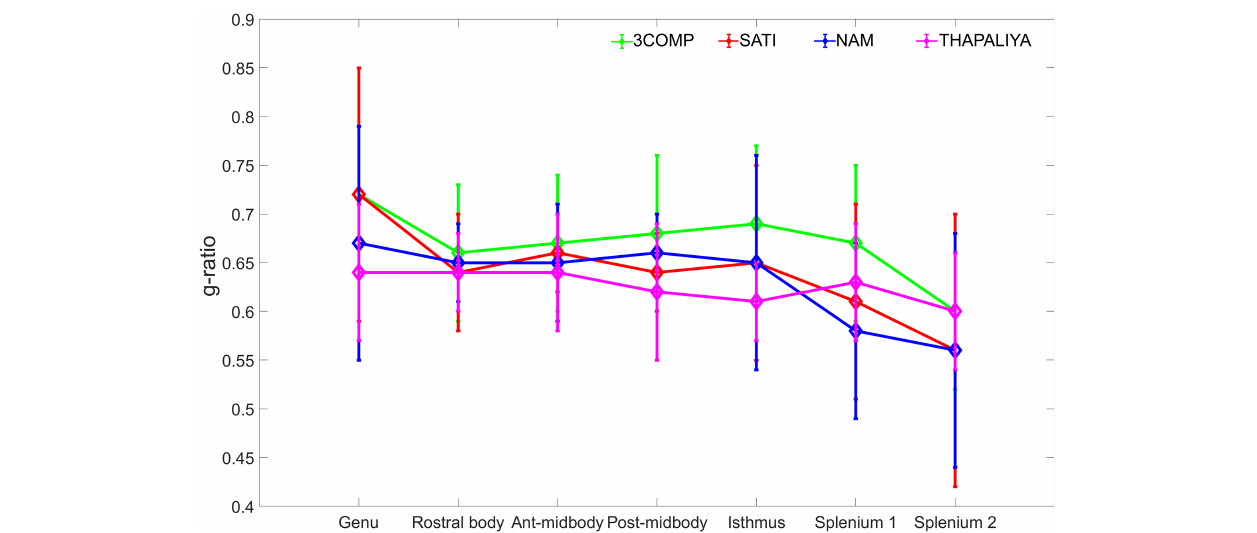
FIGURE 4 | Illustration of g-ratio variations calculated using the myelin water fraction (MWF) and axonal water fraction (AWF) model parameters across the corpus callosum using the various three-compartment models. Mean values were calculated based on data from 10 participants, and error bars represent inter-participant standard deviations.